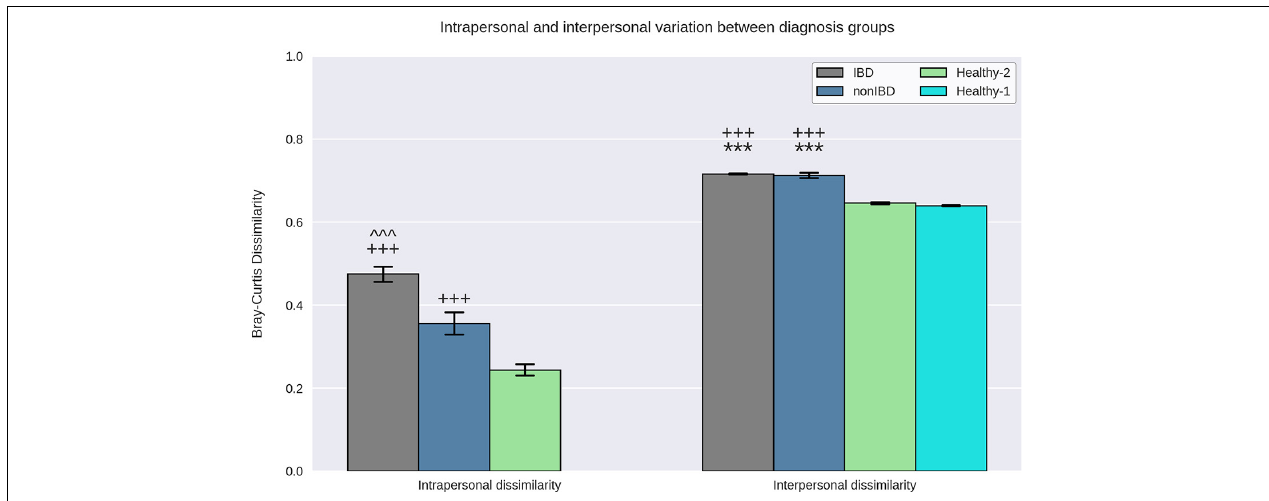
FIGURE 2 | Interpersonal and intrapersonal variation. Bray–Curtis dissimilarities between replicate samples from the same subject were used to quantify intrapersonal variation while the Bray–Curtis dissimilarities between samples from different subjects were used to quantify interpersonal variation. IBD samples demonstrated elevated intrapersonal variation relative to non-IBD and Healthy-2 samples and non-IBD samples demonstrate elevated intrapersonal variation relative to Healthy-2 samples. IBD and non-IBD samples both demonstrated elevated interpersonal variation relative to the Healthy-1 and Healthy-2 samples. It was observed that replicate samples from the same subject were significantly more similar to each other than to samples from other subjects indicating that all diagnosis groups exhibited greater interpersonal variation than intrapersonal variation. *** Indicates p -value < 0.0005, relative to Healthy-1. +++ indicates p -value < 0.0005, relative to Healthy-2. ˆˆˆ indicates a p -value < 0.0005, relative to non-IBD.